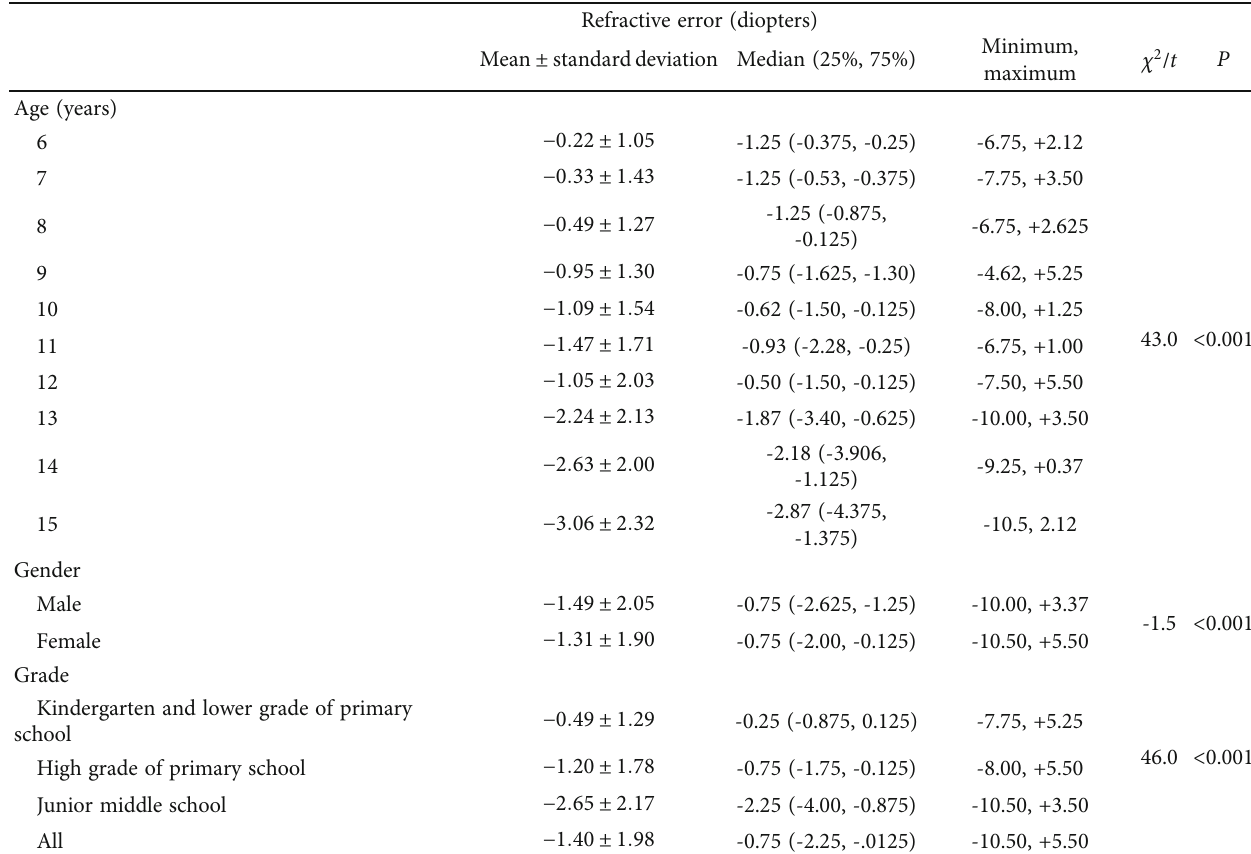
Table 6: Refractive error (diopters) strati fi ed by age, gender, and grade. Refractive error